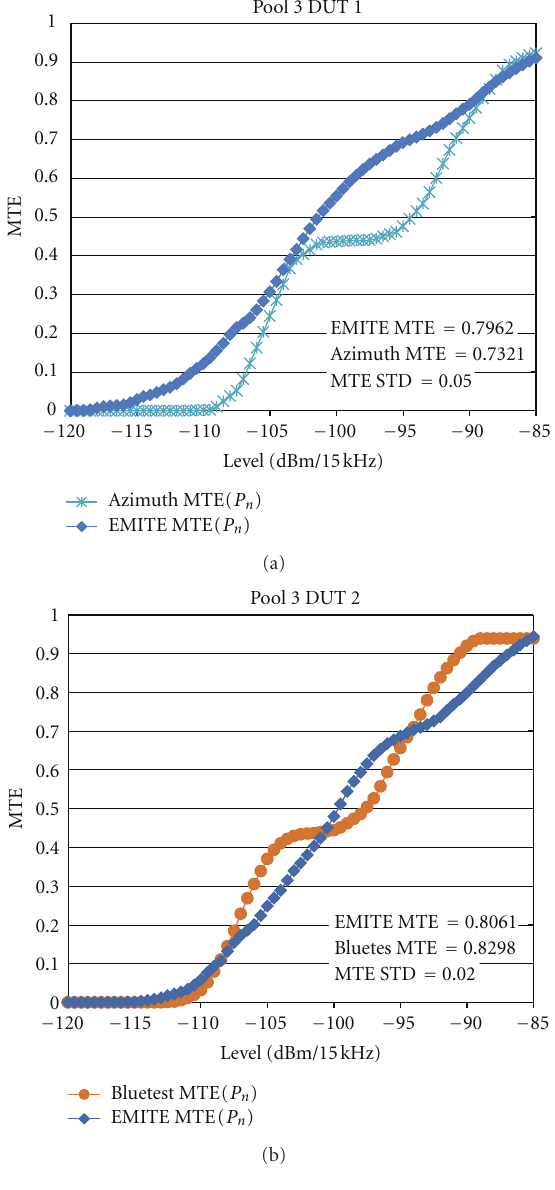
Figure 3: MTE for Pool 3 with the RC methodology.